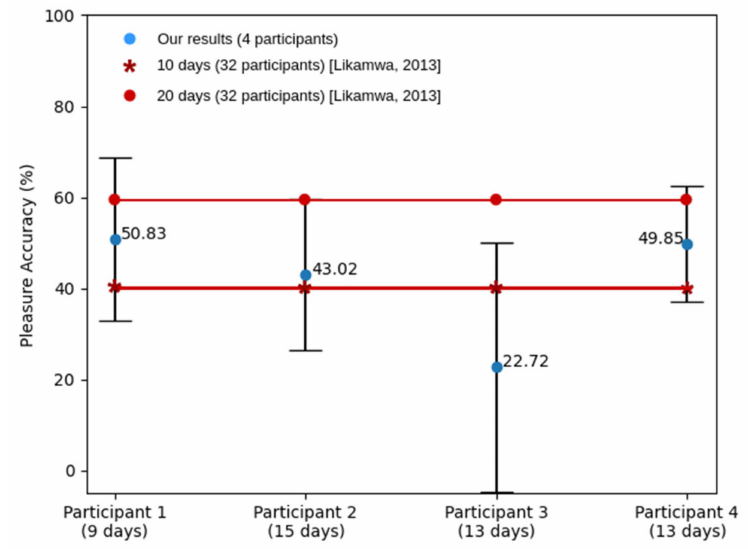
Figure 16. Accuracy metric obtained for the leave-one(day)-out experiment to predict pleasure (or happiness) values. Error bars represent standard deviation. Red asterisk and Circle dots represent the mean pleasure accuracy for datasets of 10 and 20 days respectively stated by R. Likamwa et al. [119].